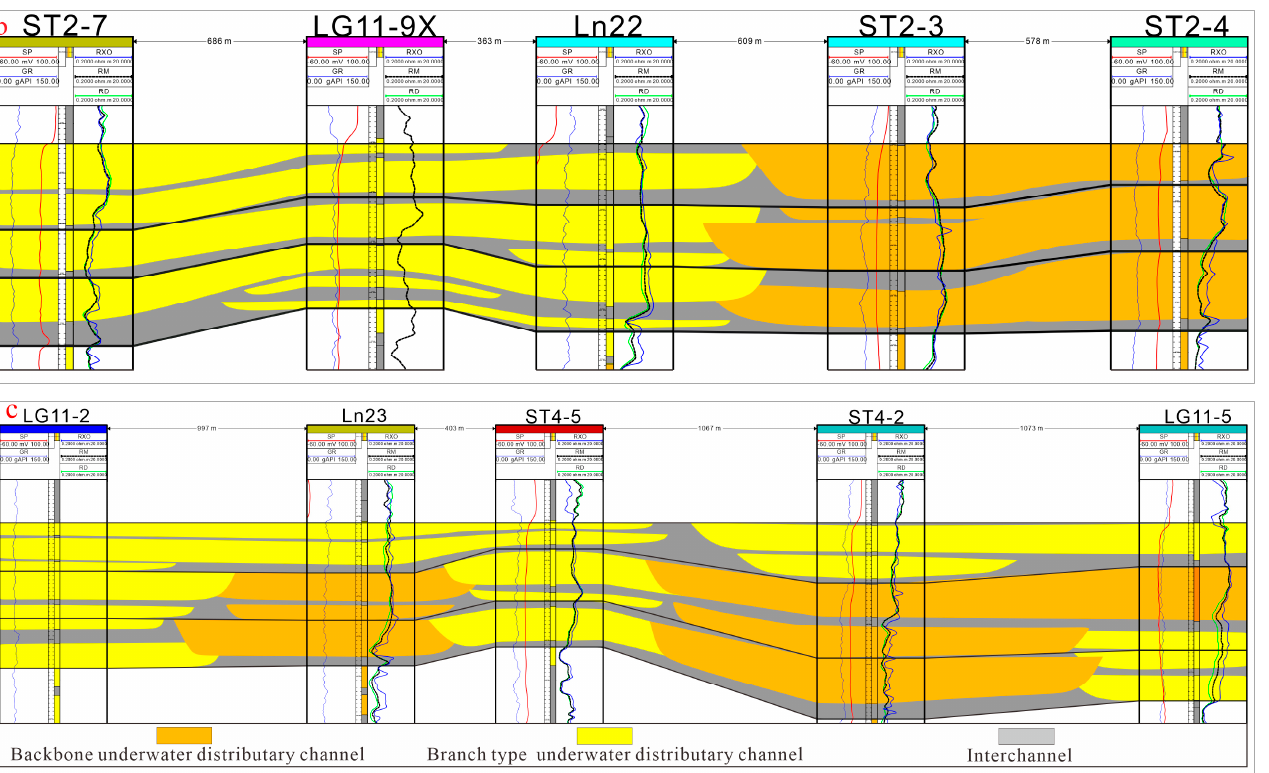
Figure 8. Profile of well-tie architecture in the Sangtamu oilfield (profile position shown in Figure 1c) (( a ) section a; ( b ) section b; ( c ) section c).